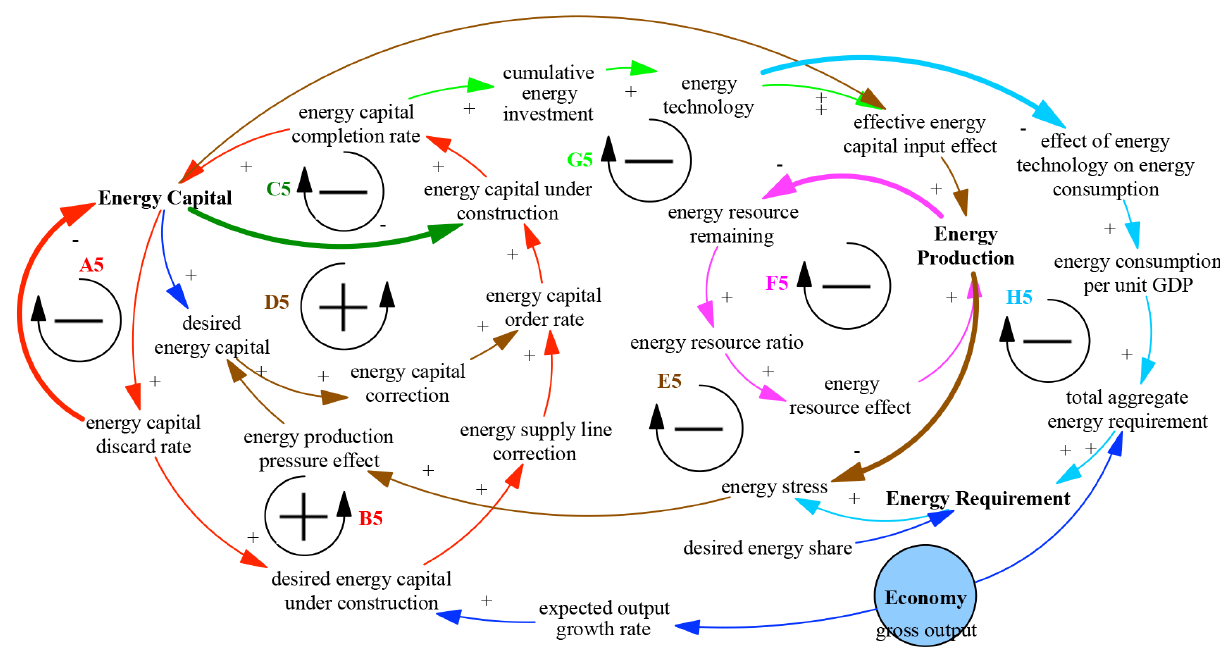
Figure 7. CLD in the energy sector.